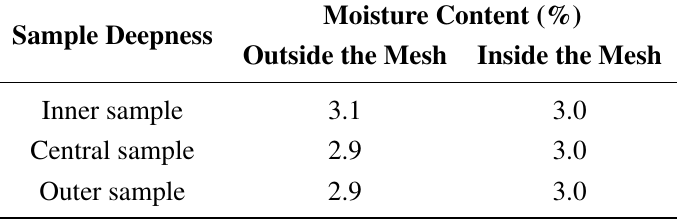
Table 3. Moisture content at different depths of the test